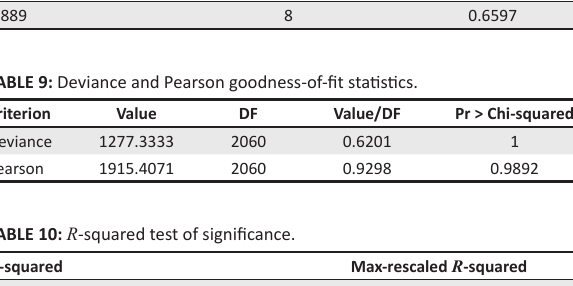
TABLE 8: Hosmer and Lemeshow goodness-of-fit test. Chi-squared DF